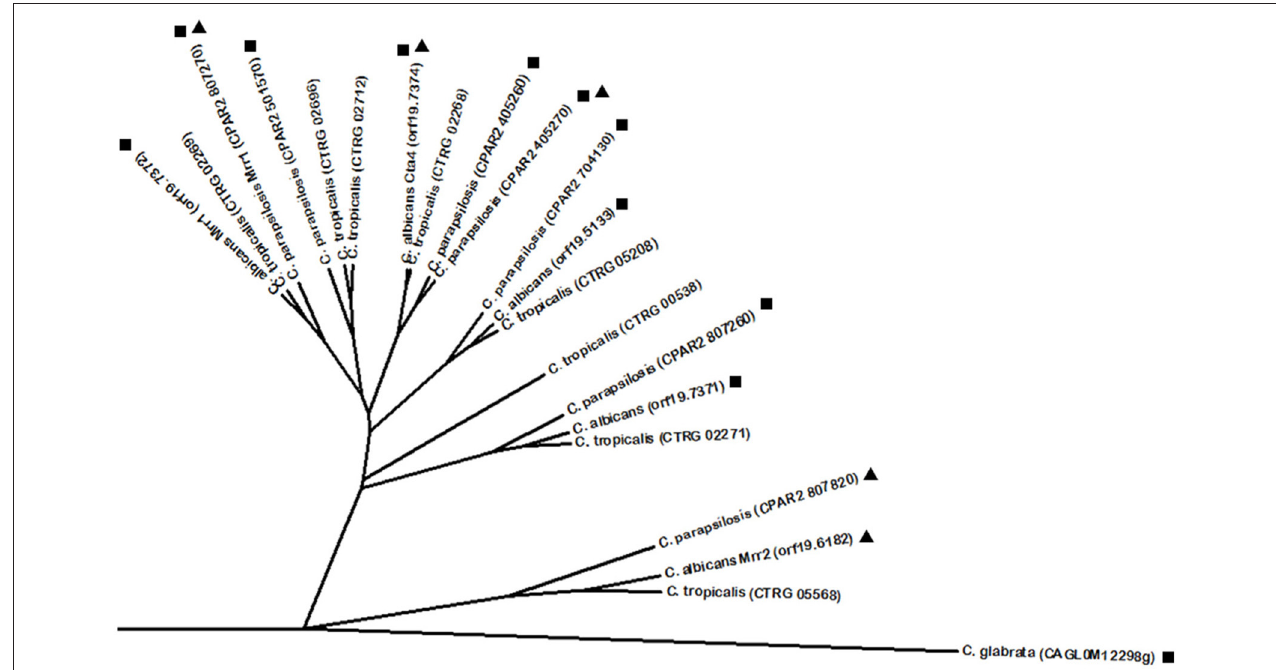
FIGURE 1 | Phylogenetic analysis of the C. albicans Mrr1 and Mrr2 homologs. Phylome predicted homologs of Mrr1 are marked with ( (cid:4) ). Phylome predicted homologs of Mrr2 are marked with ( N ). Unmarked branches represent additional proteins showing some degree of similarity identified by BLASTp ( E < 10 − 50 ). The tree was constructed using the Molecular Evolutionary Genetics Analysis (MEGA 7) software ( Kumar et al., 2016). Multiple alignments of the amino acid sequences were calculated by ClustalW algorithm ( Sneath and Sokal, 1973). The tree is drawn to scale, with branch lengths in the same units as those of the evolutionary distances used to infer the phylogenetic tree. The evolutionary distances were computed using the JTT matrix-based method (Jones et al., 1992) and are in the units of the number of amino acid substitutions per site. The rate variation among sites was modeled with a gamma distribution (shape parameter =